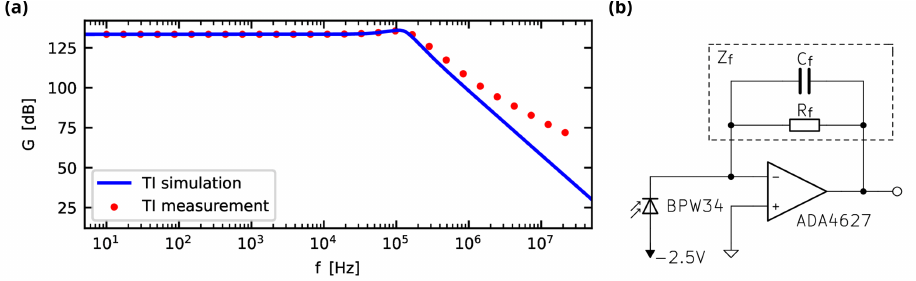
Figure A1. ( a ) Frequency response of the TIA for a gain of 4.7 M Ω . ( b ) TI circuit. The photodiode was reverse-biased at − 2.5